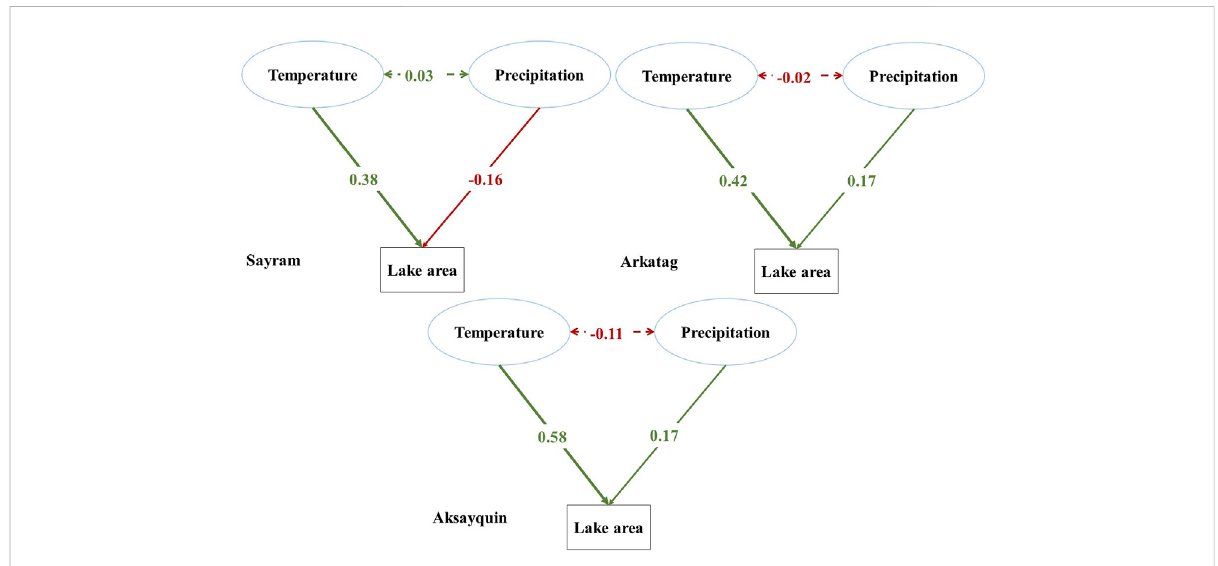
FIGURE 11 Results of structural equation model analysis of the in fl uencing factors of typical mountain lake area changes in